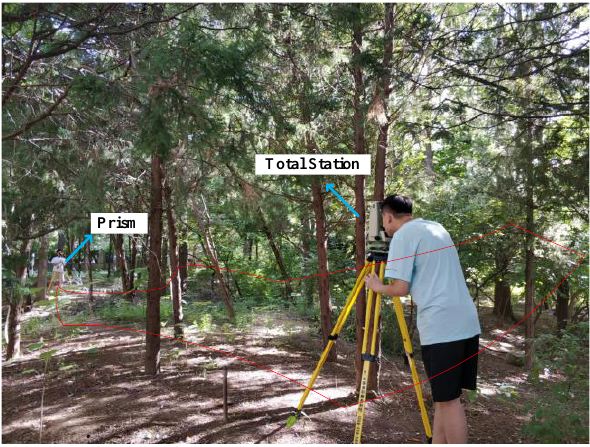
Figure 7. Forest environment.